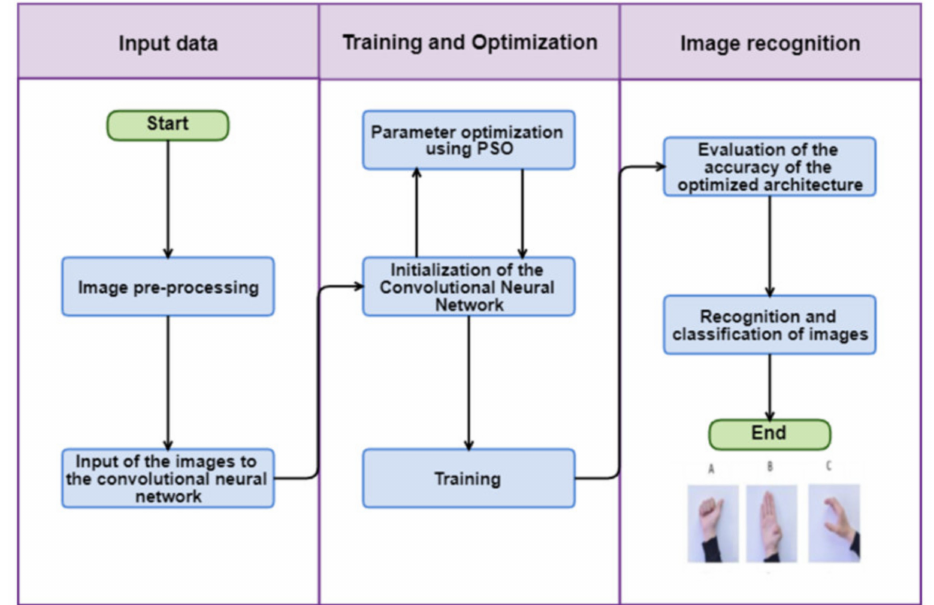
Figure 6. General CNN optimization process using the PSO algorithm. The letters A, B, and C stand the illustrated sign language in image